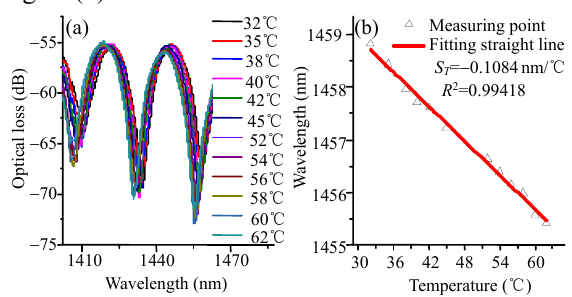
Fig. 13 Spectra and temperature characteristics: (a) spectra at different temperatures and (b) wavelength and temperature relationship